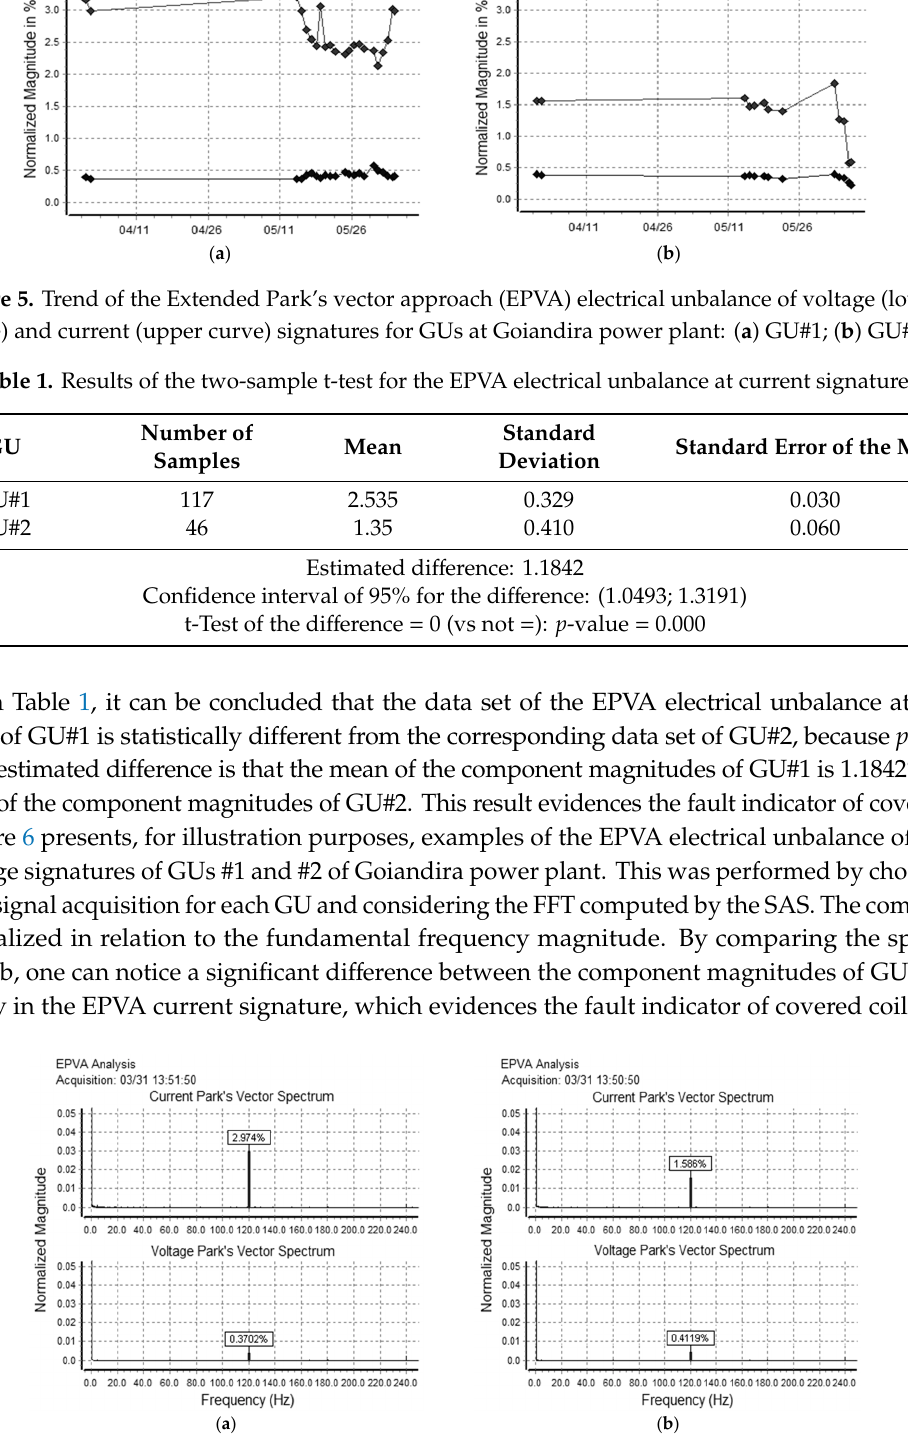
Figure 6. EPVA electrical unbalance of current and voltage signatures of the Goiandira GUs: ( a ) GU#1; ( b ) GU#2.